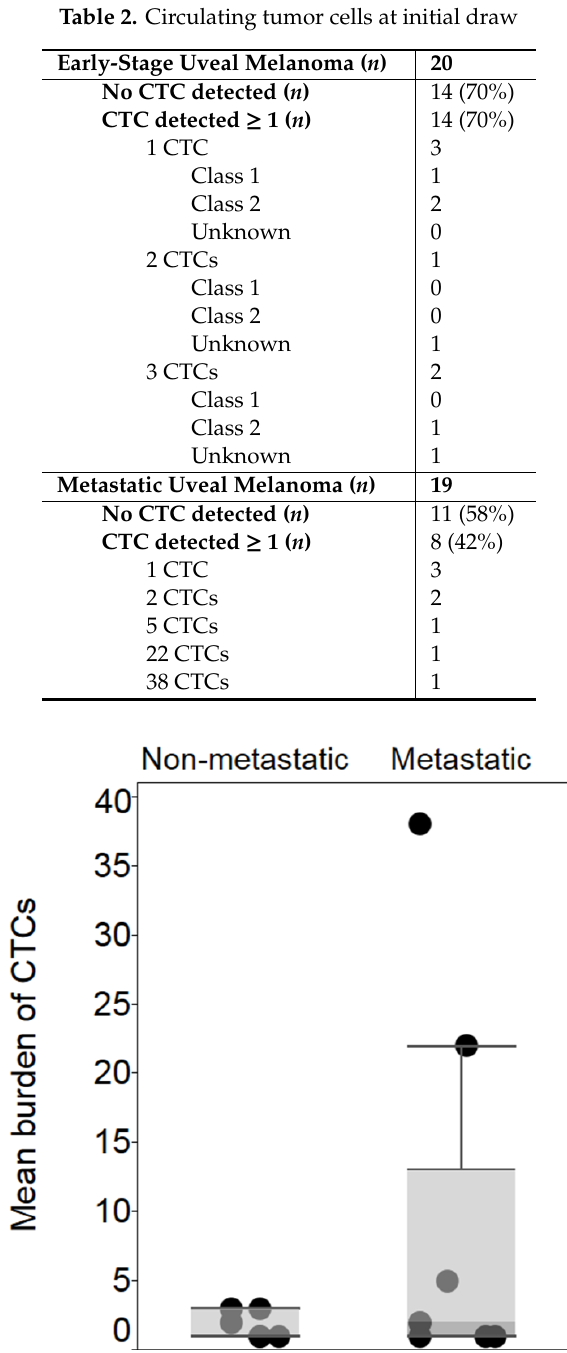
Figure 1. Mean burden of CTC in early-stage, 1.83 CTCs (standard deviation: 0.98), vs. metastatic uveal melanoma 9 CTCs (standard deviation: 13.7). p > 0.05 .